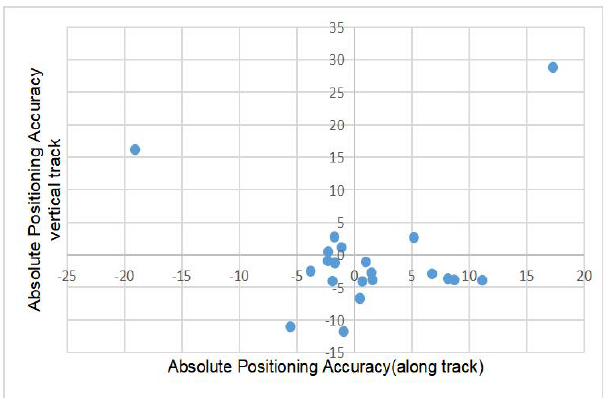
Figure 6. Spatial distribution of absolute positioning